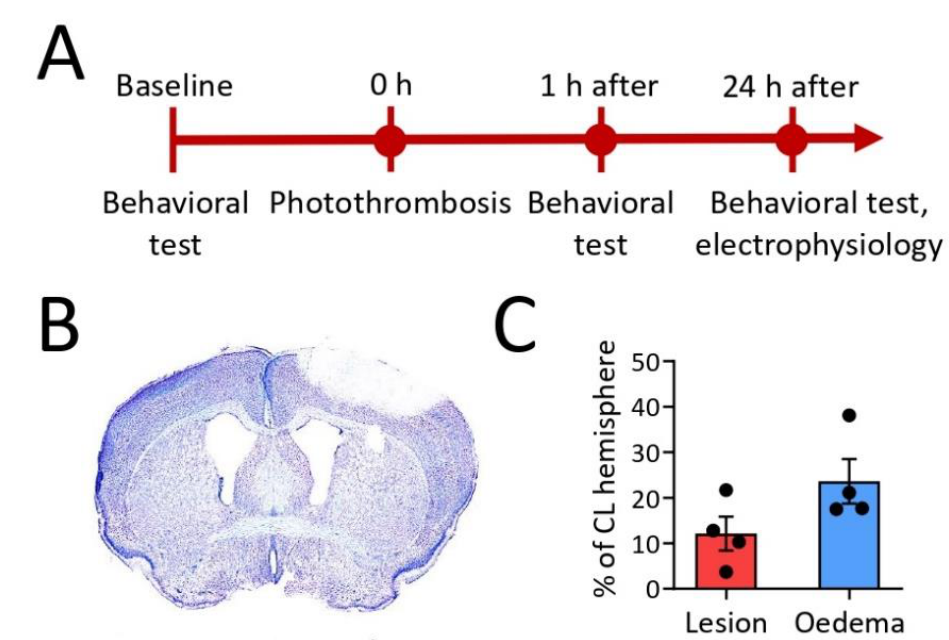
Figure 1. The study design ( A ). Typical ischemic damage to the motor cortex not affecting the corpus callosum in the ipsilateral (IL) hemisphere ( B ). Lesion size and edema as a percentage of the contralateral hemisphere (CL) ( C ).